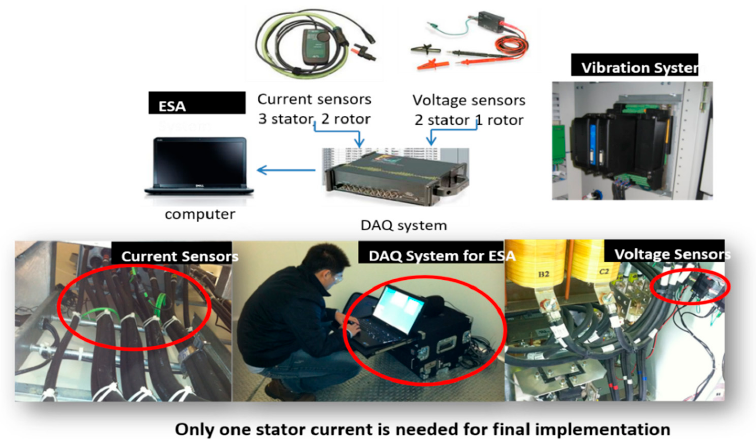
Figure 10. WT causal chains and monitoring components.